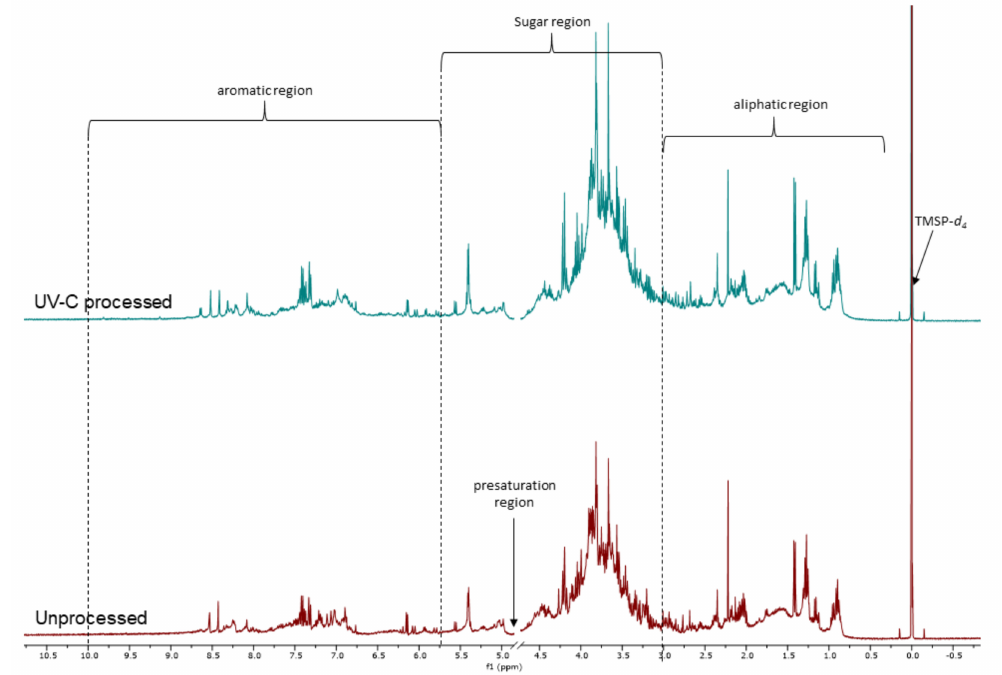
Figure 3. 1 H NMR (400 MHz, D 2 O) spectra of UV-C processed (dose 16.5 ± 0.21 mJ / cm 2 and pH 3.5) and unprocessed (pH 3.5)